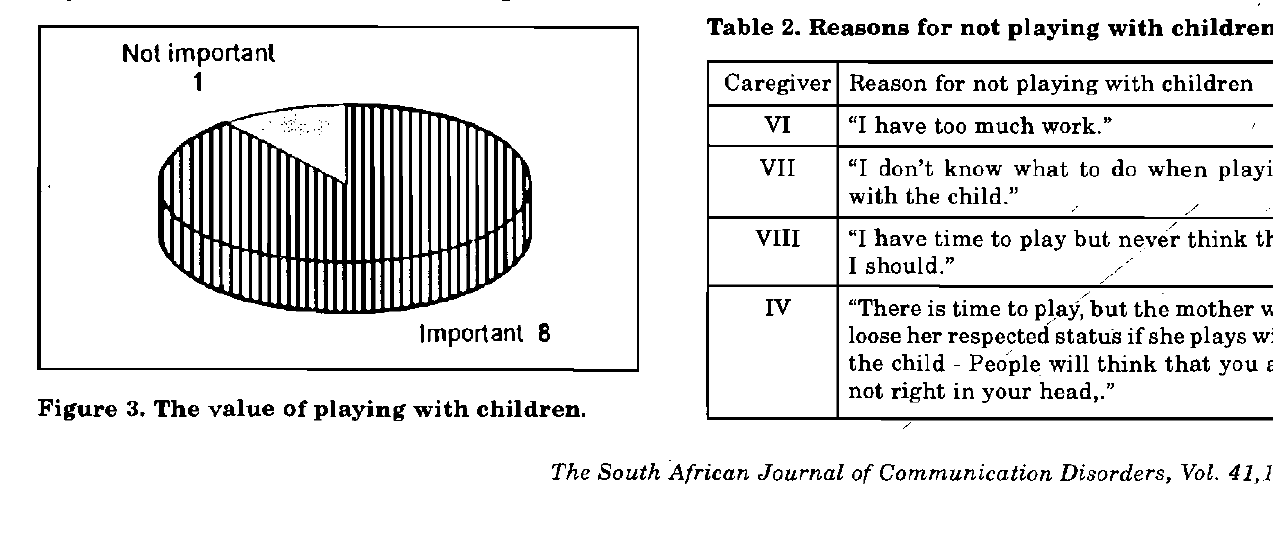
Figure 2. The value of children talking.